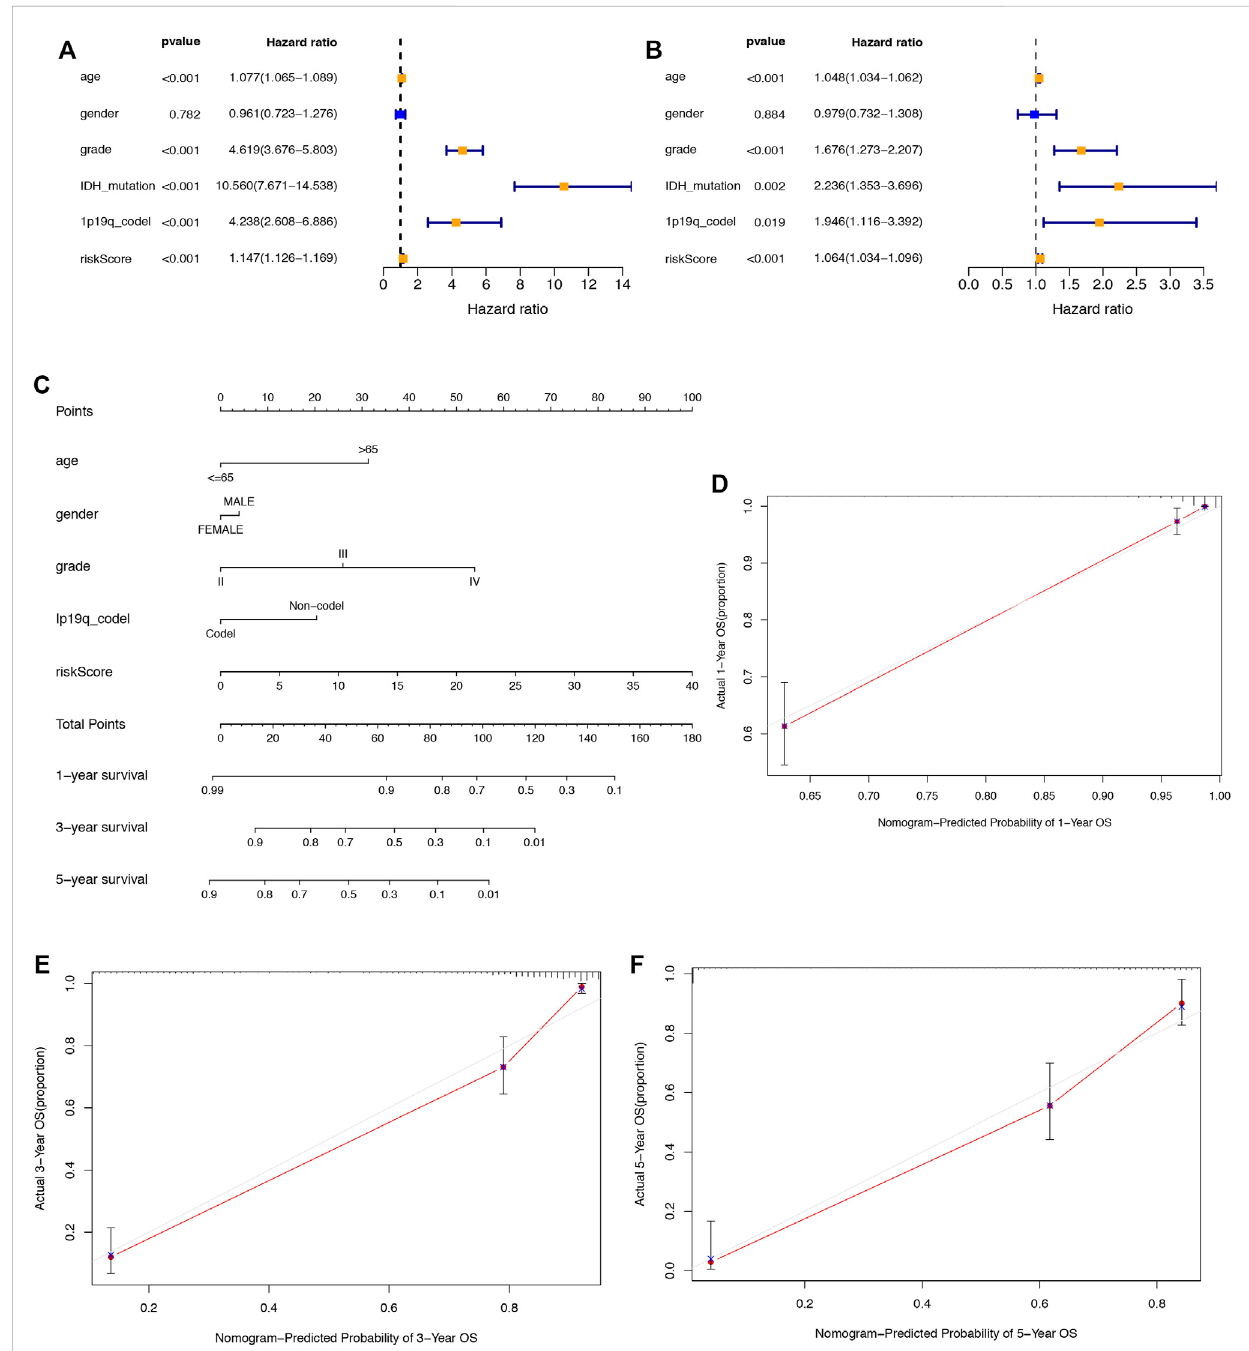
FIGURE 6 Assessment of the prognostic signature of the SRlncRNAs in glioma. (A) The results of univariate Cox regressionanalysis of the riskscore and clinical factors. (B) The resultsofmultivariateCox regression analysis oftheriskscore and clinicalfactors. (C) The nomogramoftheriskscore and clinicalfactors. (D – F) the calibration curves of the nomogram displaying the concordance between predicted and observed 1-, 3-, and 5-year